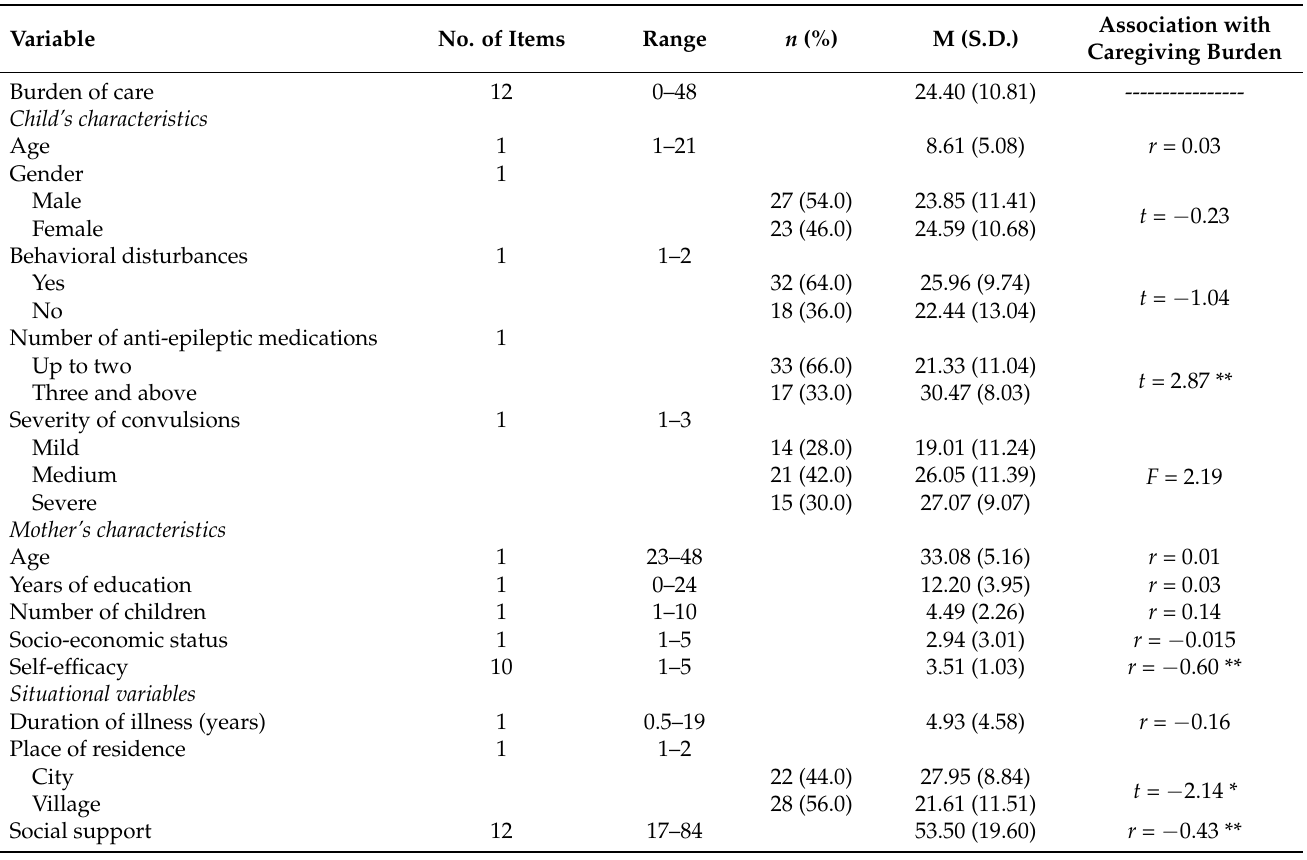
Table 1. Mothers’/children’s characteristics and associations between study measures and mothers’ caregiving